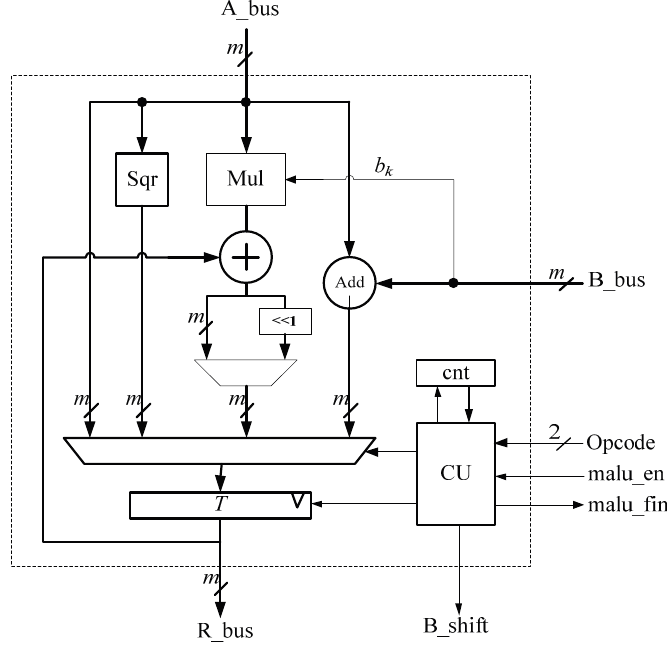
Figure 3. Structure of the modular arithmetic logic unit